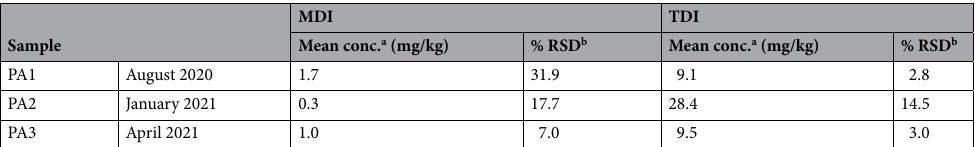
Table 3. Concentration of MDI and TDI in real PAs samples expressed in mg/kg. a Mean concentration calculated as the average of three repeated analyses of the same sample. b Relative standard